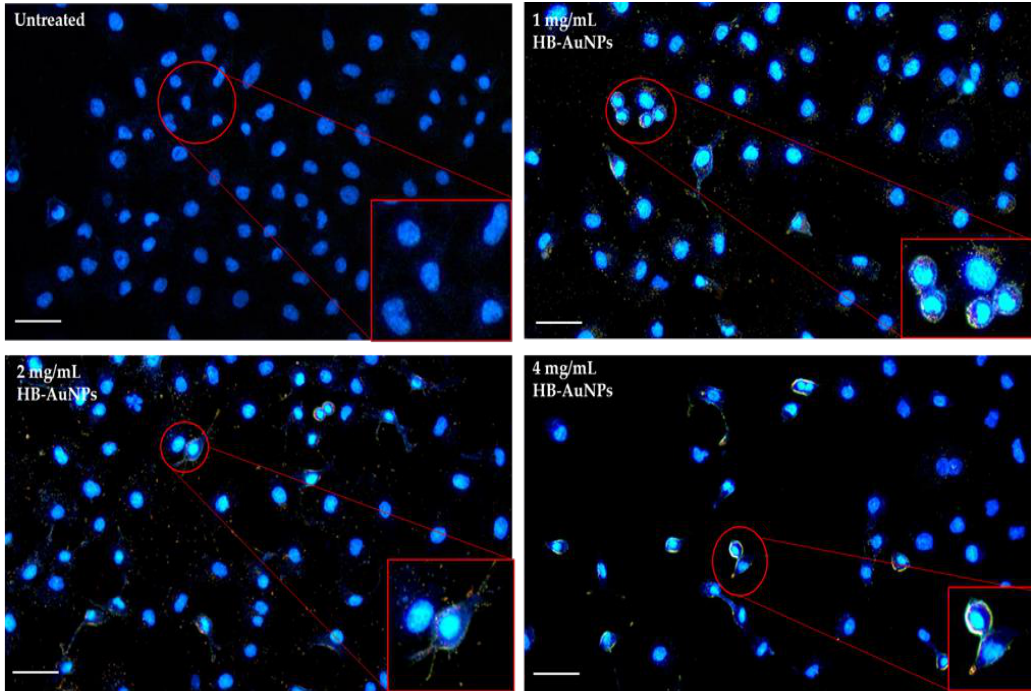
Figure 8. Uptake of HB-AuNPs by Caco-2 cells. Blue represents the nucleus of the cells stained by DAPI and yellow represents the distribution of the HB-AuNPs within the cells. Scalebar was set at 100 µ m. The red circle represent the part that was zoomed in the red